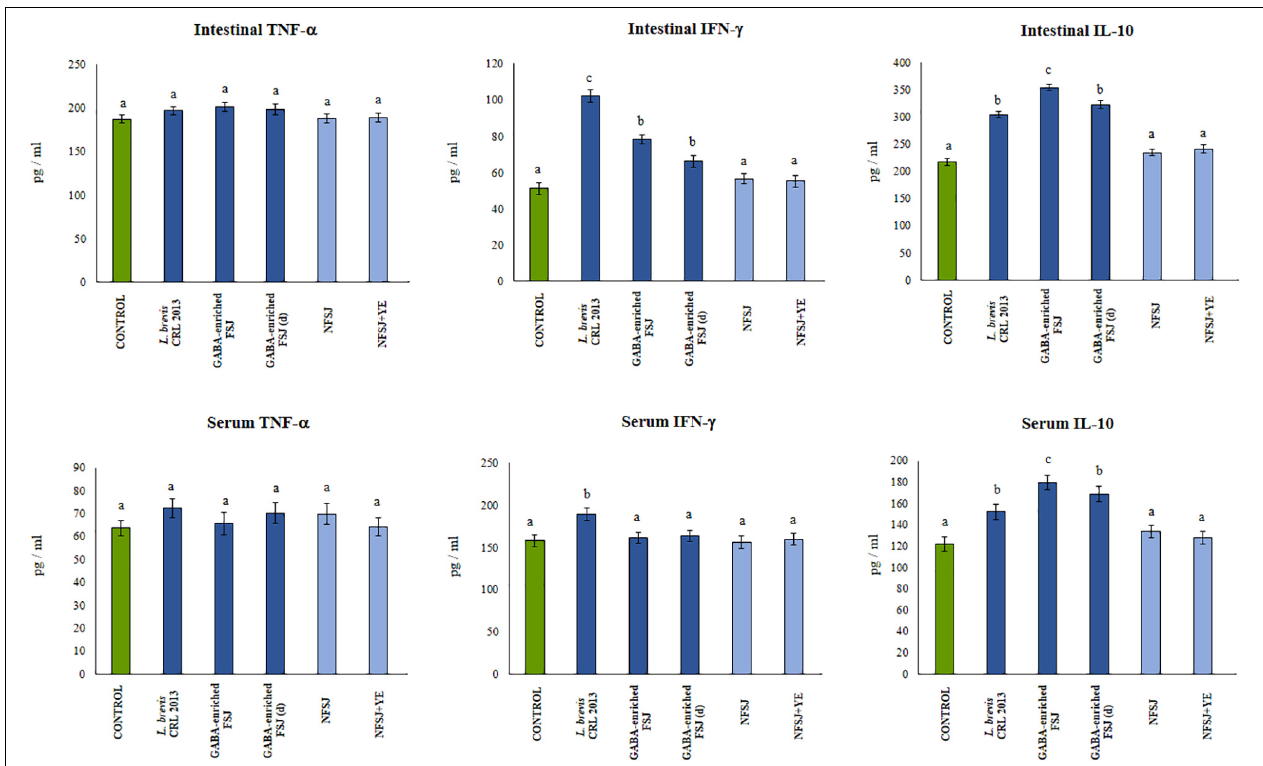
FIGURE 4 | Effect of L. brevis CRL 2013, GABA-enriched strawberry fermented juice (FSJ) and diluted (d) GABA-enriched FSJ on intestinal and serum cytokines and chemokines in mice. Animals treated with NFSJ or NFSJ supplemented with YE were used for comparisons. Results are expressed as mean ± SD. Means for each bar without a common letter differ significantly. Significance with Tukey’s HSD post hoc test following a one-way ANOVA is indicated as p <